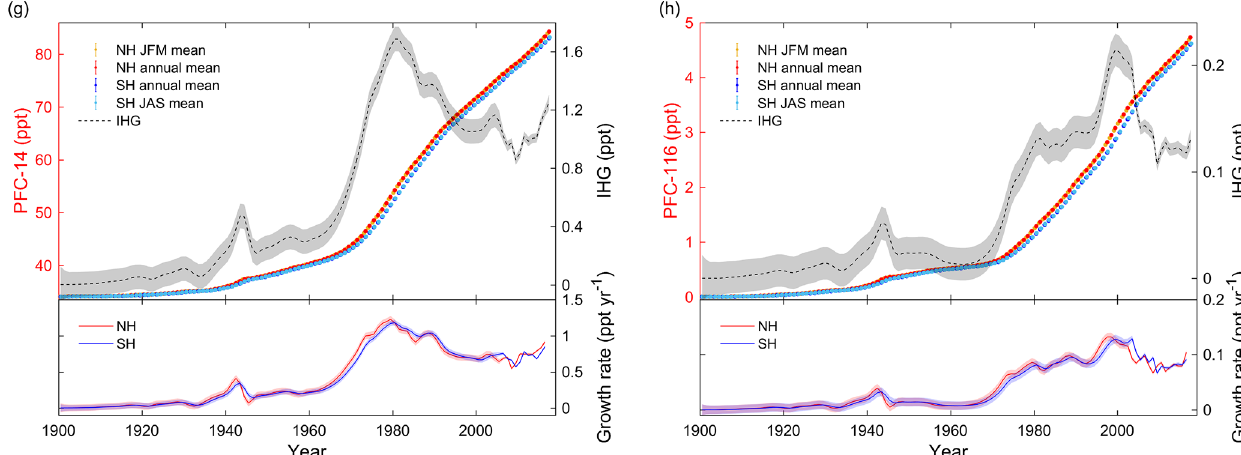
Figure 2. (a) HCFC-22: the top of the panel shows the JFM means (NH), annual means (NH and SH) and JAS means (SH) of atmospheric mole fractions and the interhemispheric gradients (IHG, in black, using the right axes). The lower section shows the annual growth rates in pptyr − 1 . Shadings in the figure reflect the uncertainties. (b) Similar to Fig. 2a, but for HCFC-141b. (c) Similar to Fig. 2a, but for HCFC- 142b. (d) Similar to Fig. 2a, but for HFC-134a. (e) Similar to Fig. 2a, but for HFC-125. (f) Similar to Fig. 2a, but for HFC-23. (g) Similar